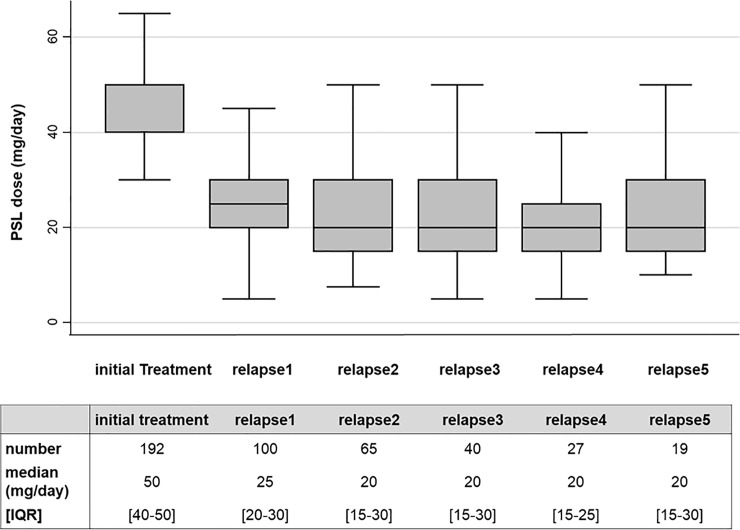
Prednisolone dose for initial treatment and relapses.Steroid dose in treatment of adult MCD from initial treatment to fifth relapse is shown in box-plots. The dosage at the start of each treatment was selected and the dosage of additional increasing until complete remission was excluded. Abbreviations: PSL, prednisolone; IQR, interquartile range.